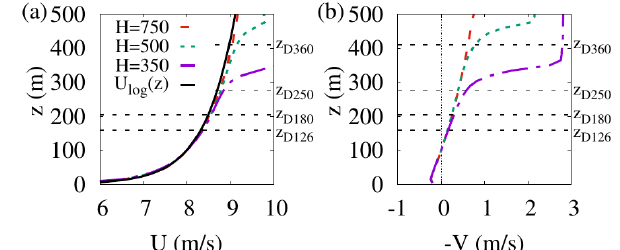
Figure 2. Influence of the tilt angle ϕ on the average power ex- tracted by the arrays of D = 126m turbines in the ABL with H = 750m. (a) Dependence on ϕ of the ratio P/P Ref of the produced power P to the P Ref power produced for the reference case when = 1 . 5 (hatched, tilted turbines are operated at the reference C (cid:48) T = 3 (solid, blue). (b) Decomposition of black) or at the higher C (cid:48) T P/P Ref into the contributions of the upwind tilted (green, hatched, bottom), middle tilted (red, cross-hatched, middle) and downwind not tilted (black, solid, top) turbine rows when tilted-rotor turbines = are operated at C (cid:48) T